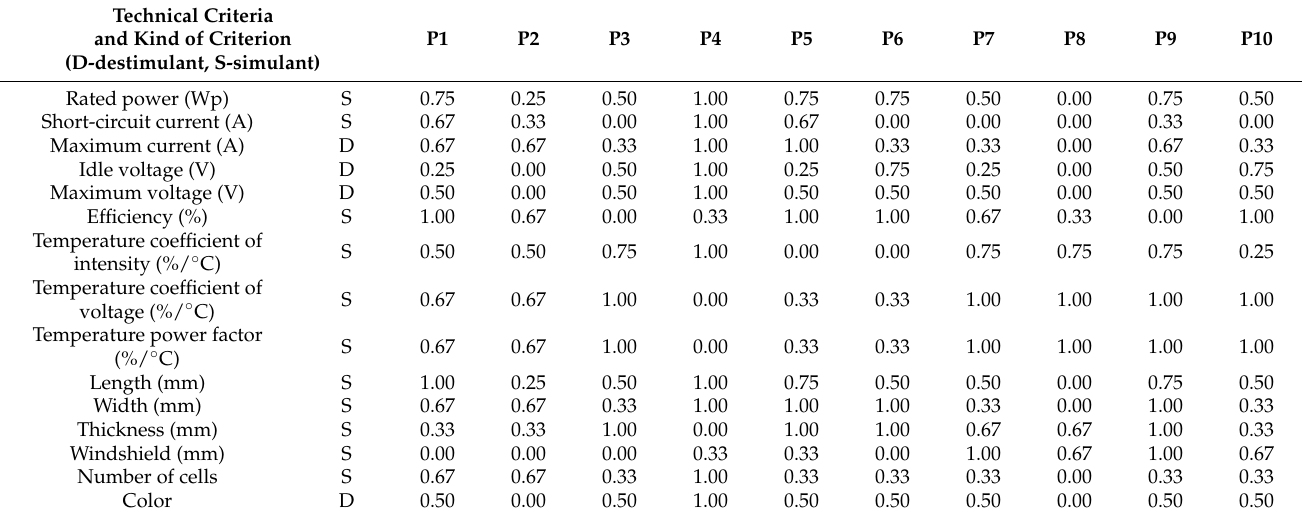
Table 7. Normalized quality of photovoltaic panels